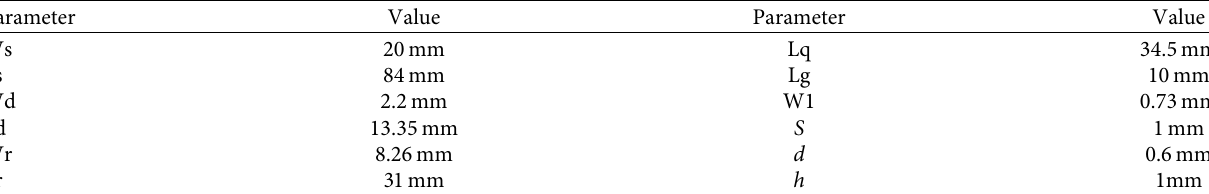
Table 1: Design parameters of the proposed omnidirectional